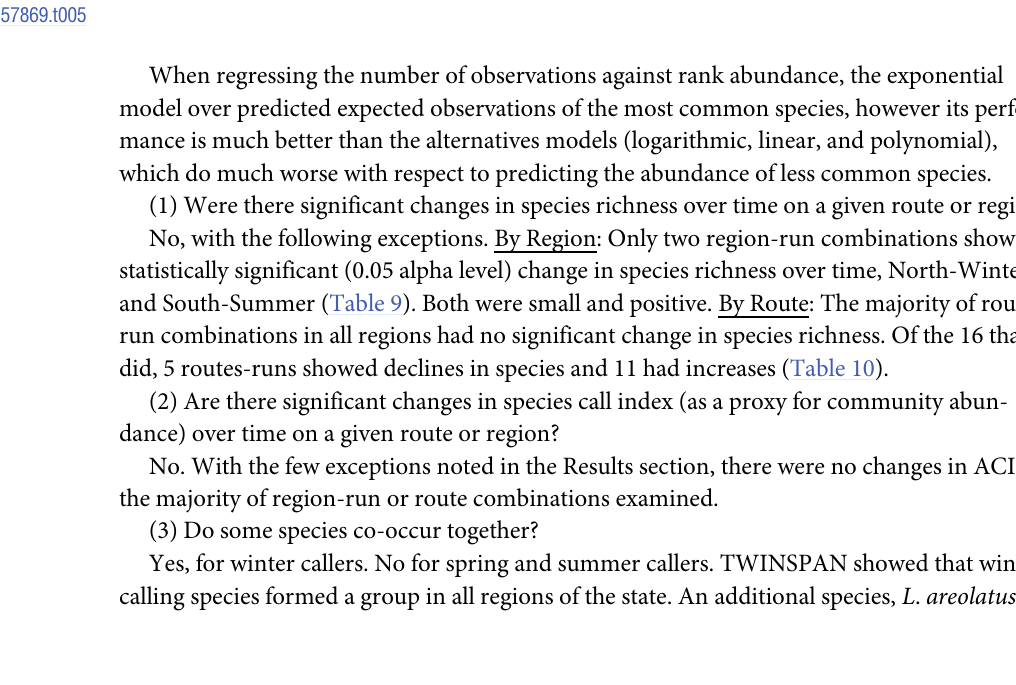
When regressing the number of observations against rank abundance, the exponential